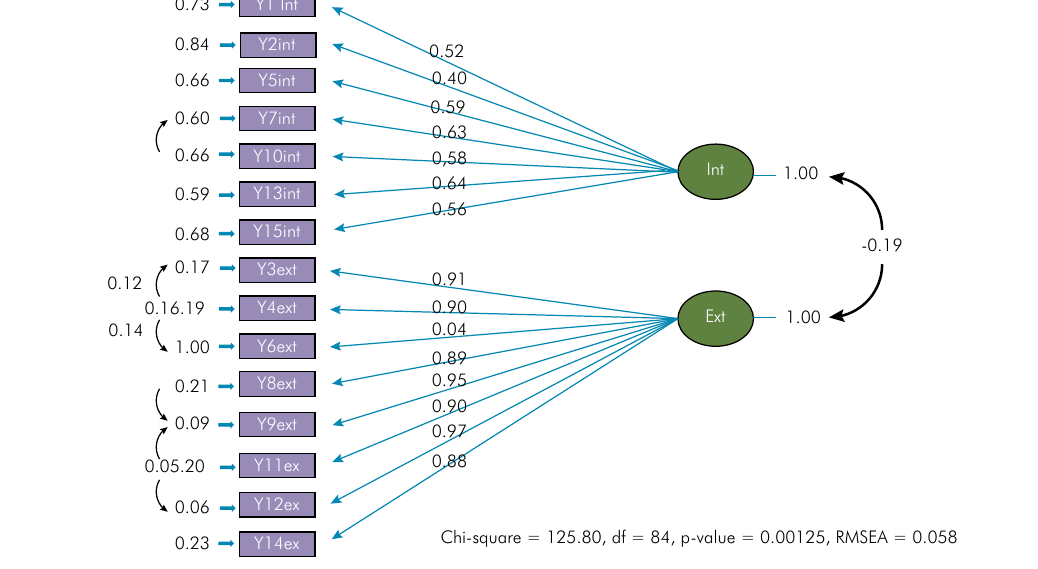
Figure 2. Significance value of DTMS cross-cultural